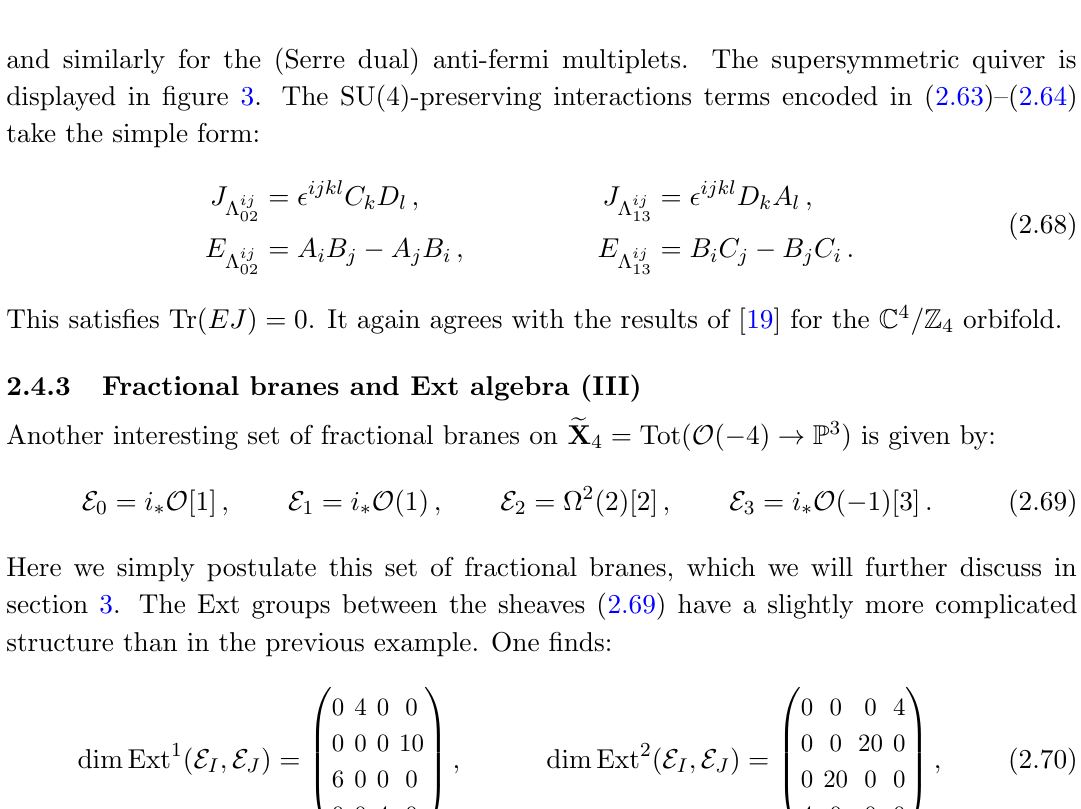
Figure 3 . The C 4 = Z 4 (1 ; 1 ; 1 ; 1) supersymmetric quiver | \theory